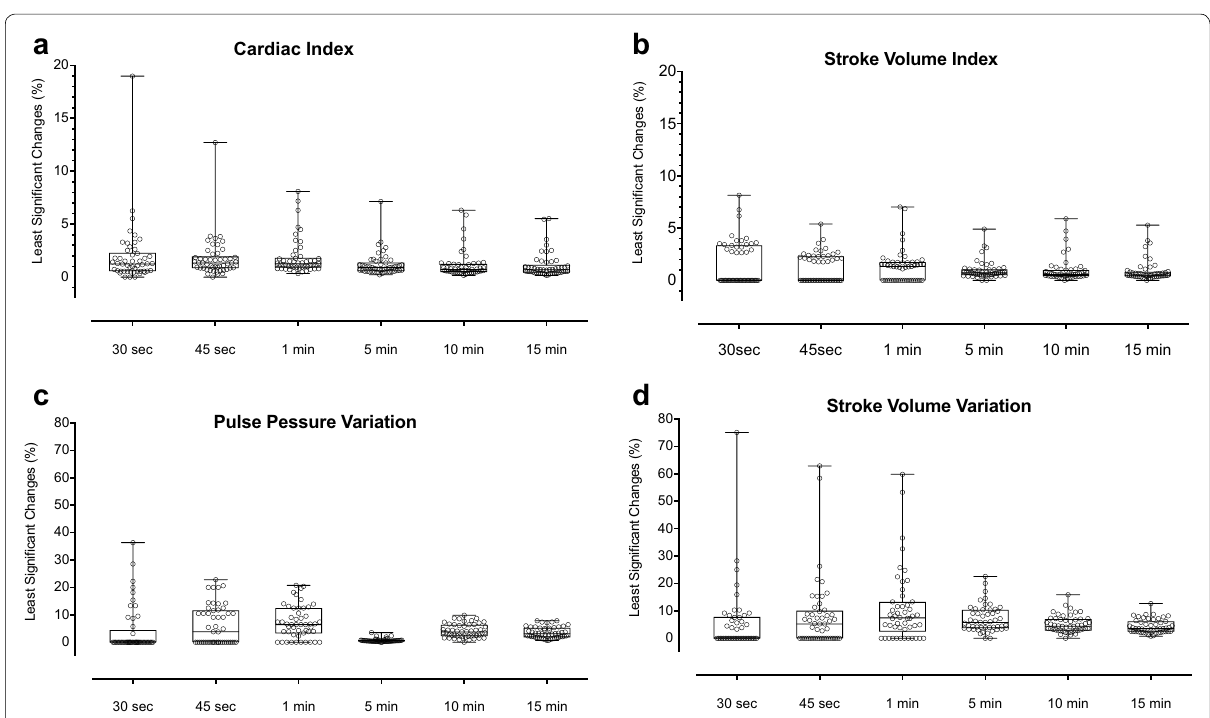
Fig. 2 a Representation of the least significant changes of cardiac index at predefined times: 30 s (s), 45 s, 60 s, 5 min (min), 10 min and 15 min). Individual values (circles) and box plot (lines corresponding to median, upper and lower bars represent 5–95th percentiles). b Representation of the least significant changes of stroke volume index at predefined times: 30 s (s), 45 s, 60 s, 5 min (min), 10 min and 15 min). Individual values (circles) and box plot (lines corresponding to median, upper and lower bars represent 5–95th percentiles). c Representation of the least significant changes of pulse pressure variation at predefined times: 30 s (s), 45 s, 60 s, 5 min (min), 10 min and 15 min). Individual values (circles) and box plot (lines corresponding to median, upper and lower bars represent 5–95th percentiles). d Representation of the least significant changes of stroke volume variation at predefined times: 30 s (s), 45 s, 60 s, 5 min (min), 10 min and 15 min). Individual values (circles) and box plot (lines corresponding to median, upper and lower bars represent 5–95th